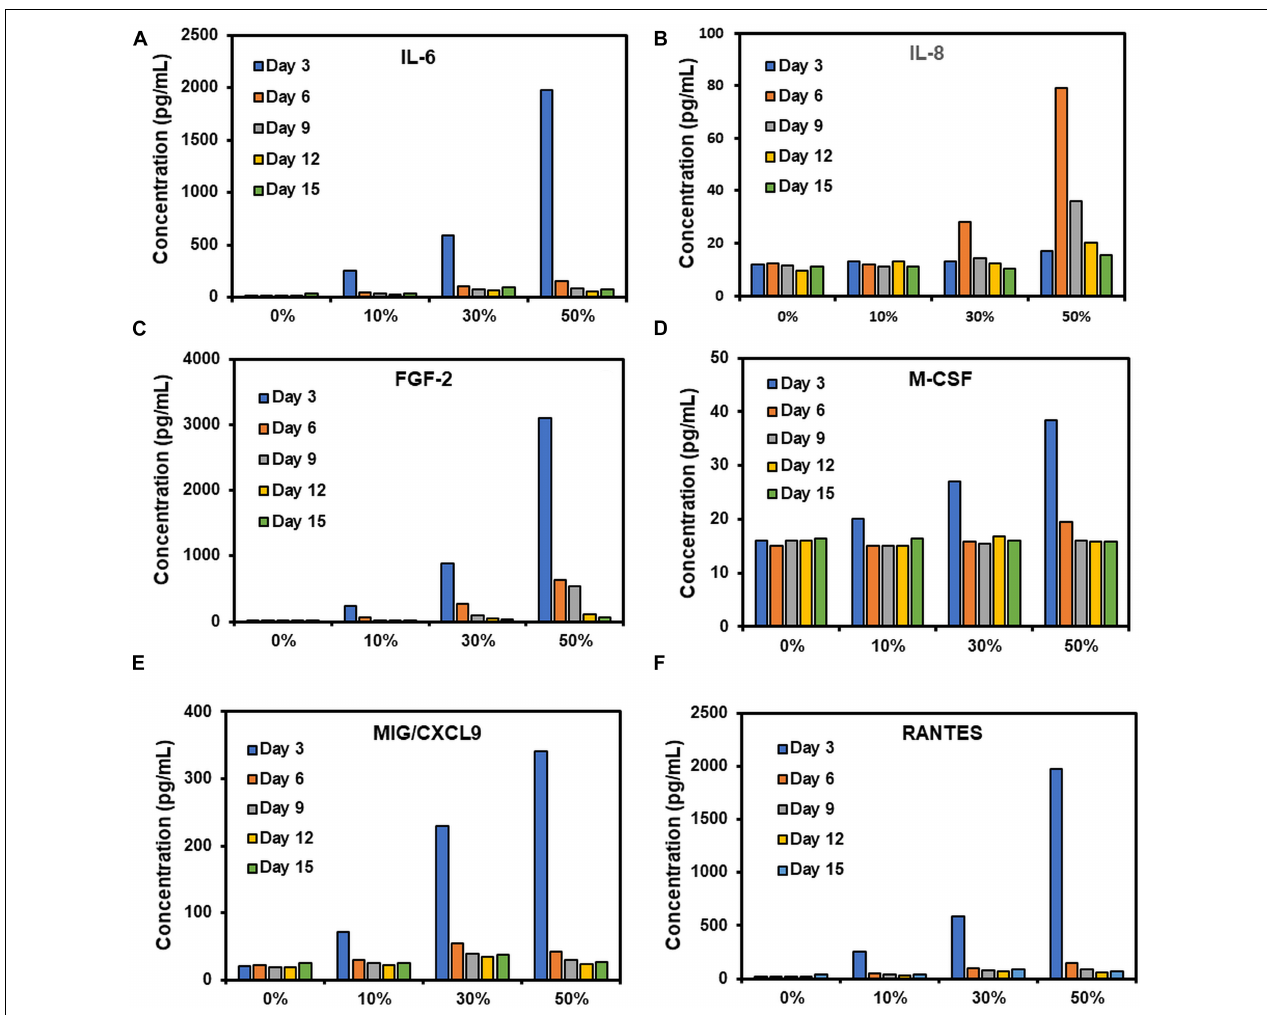
FIGURE 5 | (A–F) Assessment of temporal expression of wound healing cytokines from microfat-laden collagen constructs in vitro